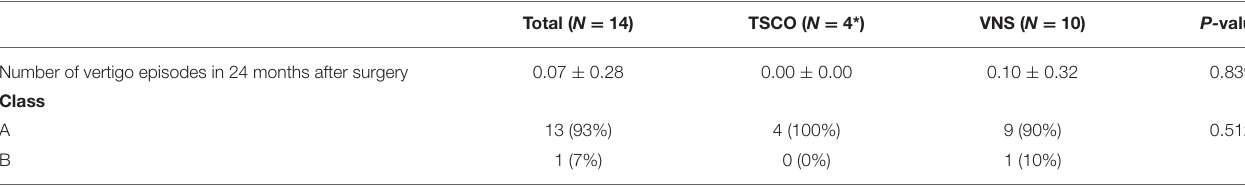
TABLE 2 | Vertigo control after surgery in patients who performed surgery more than 24 months ago.